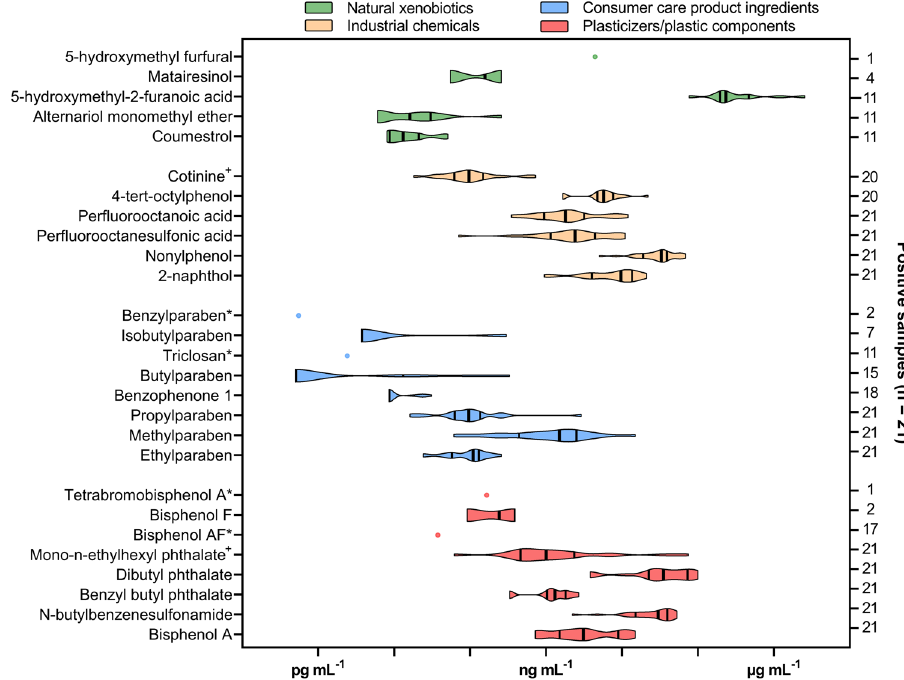
Fig. 3 Distribution of chemicals detected in premature neonates. Violin plots depict the distribution of detected concentrations of compounds in premature infant plasma samples ( n = 21). Vertical bars inside the plot indicate the fi rst quartile, the median and the third quartile. Analytes that were identi fi ed below the respective limit of quantitation (LOQ) were set to half the LOQ in this plot. Chemicals marked with (*) were only detected below the LOQ, thus no quantitative distribution is given and only a fi lled circle representing half the LOQ is displayed. Chemicals marked with ( + ) were quantitated using solvent calibration because the pooled serum intended for matrix-matched calibration was